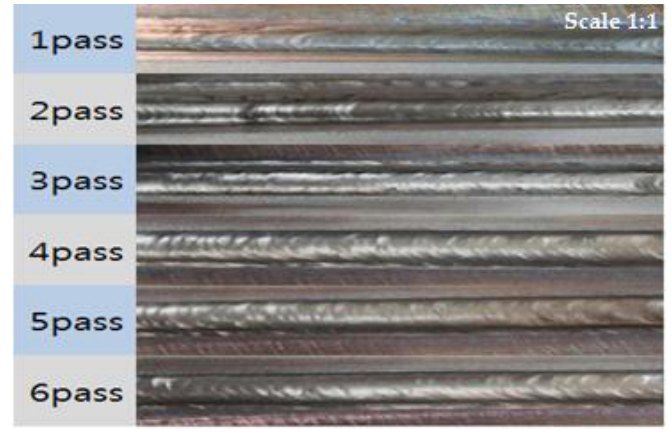
Figure 4. Weld bead appearance for each pass.